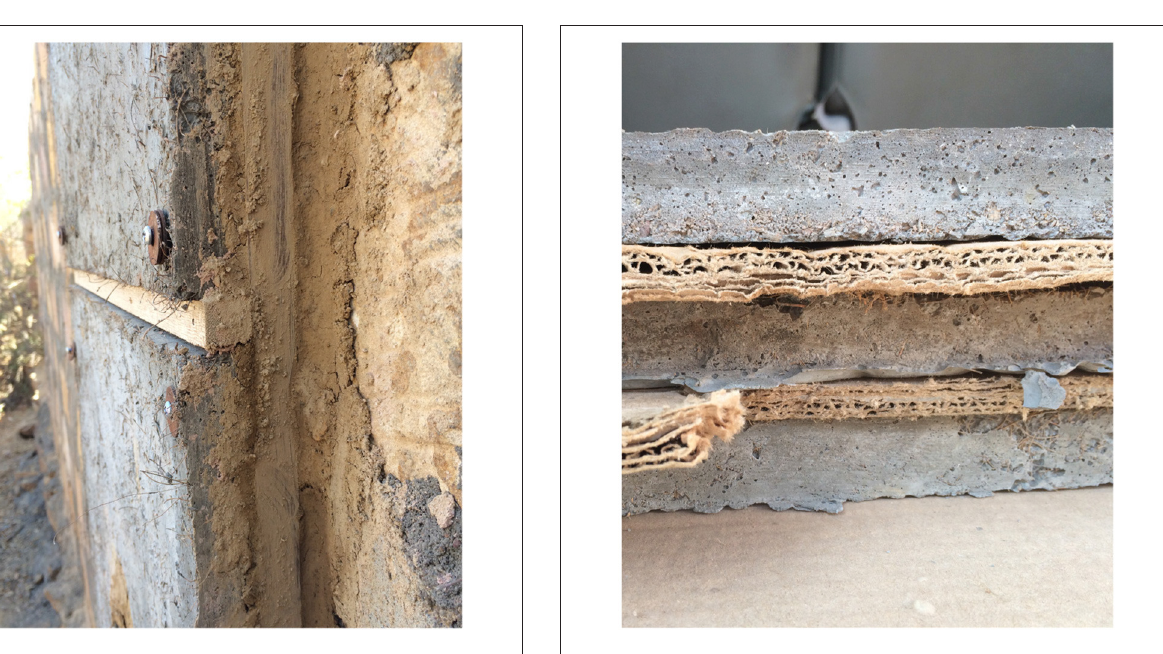
FIGURE 2 | Test wall using fiber cement panel and air gap in Bhuj.